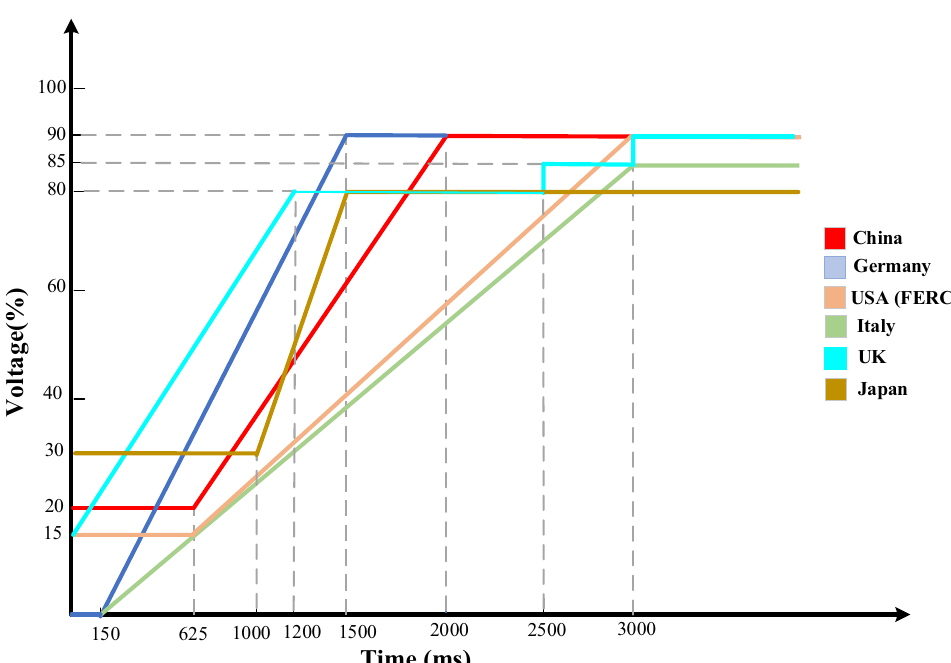
Fig. 6 Limit curves for LVRT requirements in